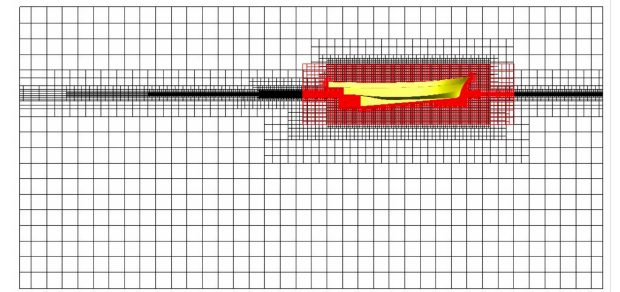
Figure 3. Computational grid of overlapping and background region (medium mesh).